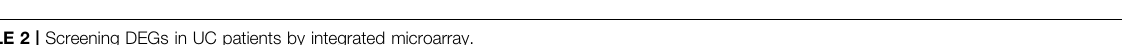
TABLE 2 | Screening DEGs in UC patients by integrated microarray.